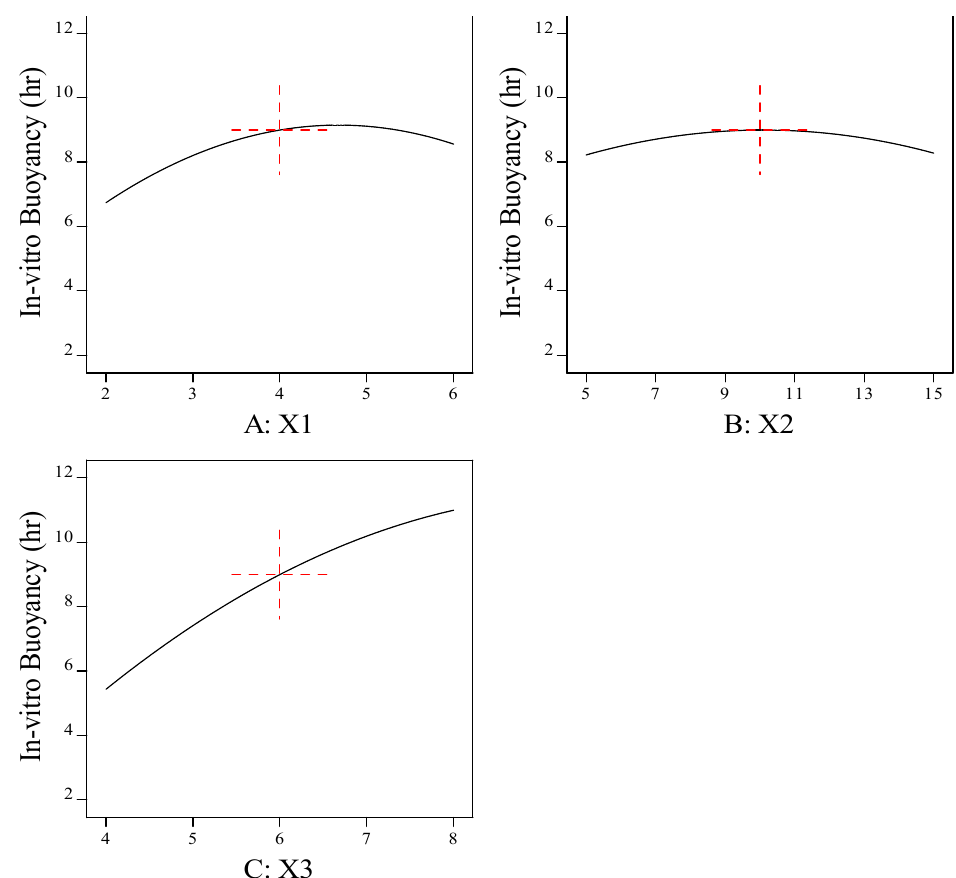
Figure 5. Main-effect plot for the effect of formulation factors (X1, X2, and X3) on the in vitro buoyancy (Y2). ( A ) Effect of sodium alginate concentration on the in vitro buoyancy (Y2); ( B ) effect of cross-linker concentration on the in vitro buoyancy (Y2); and ( C ) effect of sesame oil concentration on the in vitro buoyancy (Y2).